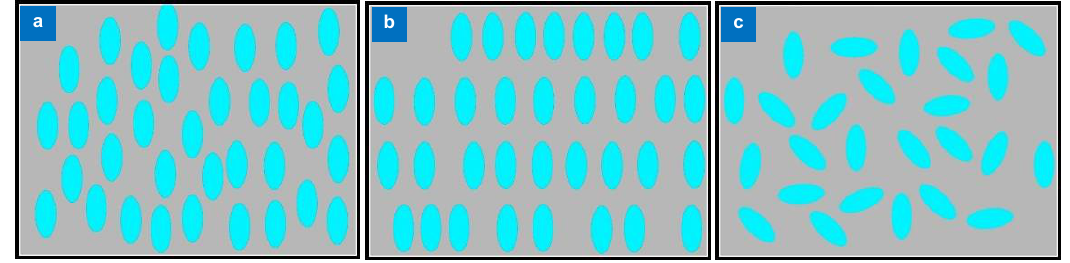
Fig. 11 | Liquid crystal molecules orientation and periodicity in ( a ) smectic , ( b ) nematic , and ( c ) isotropic phases .